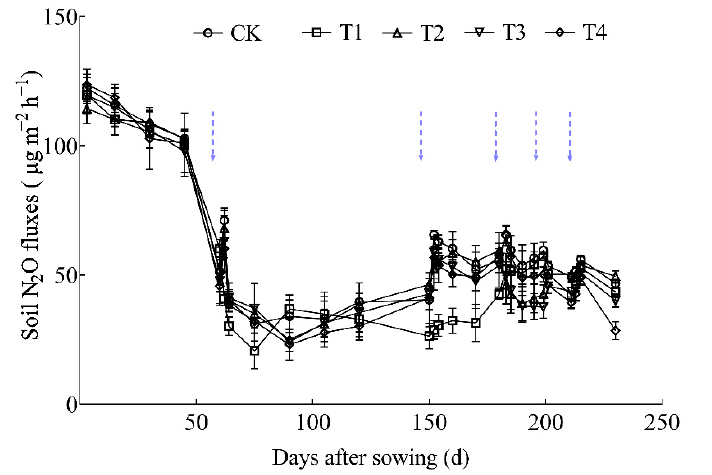
Figure 4. Changes in the soil N 2 O fluxes ( µ g m − 2 h − 1 ) under different irrigation treatments during a winter wheat growing season. The blue arrows denote irrigation.